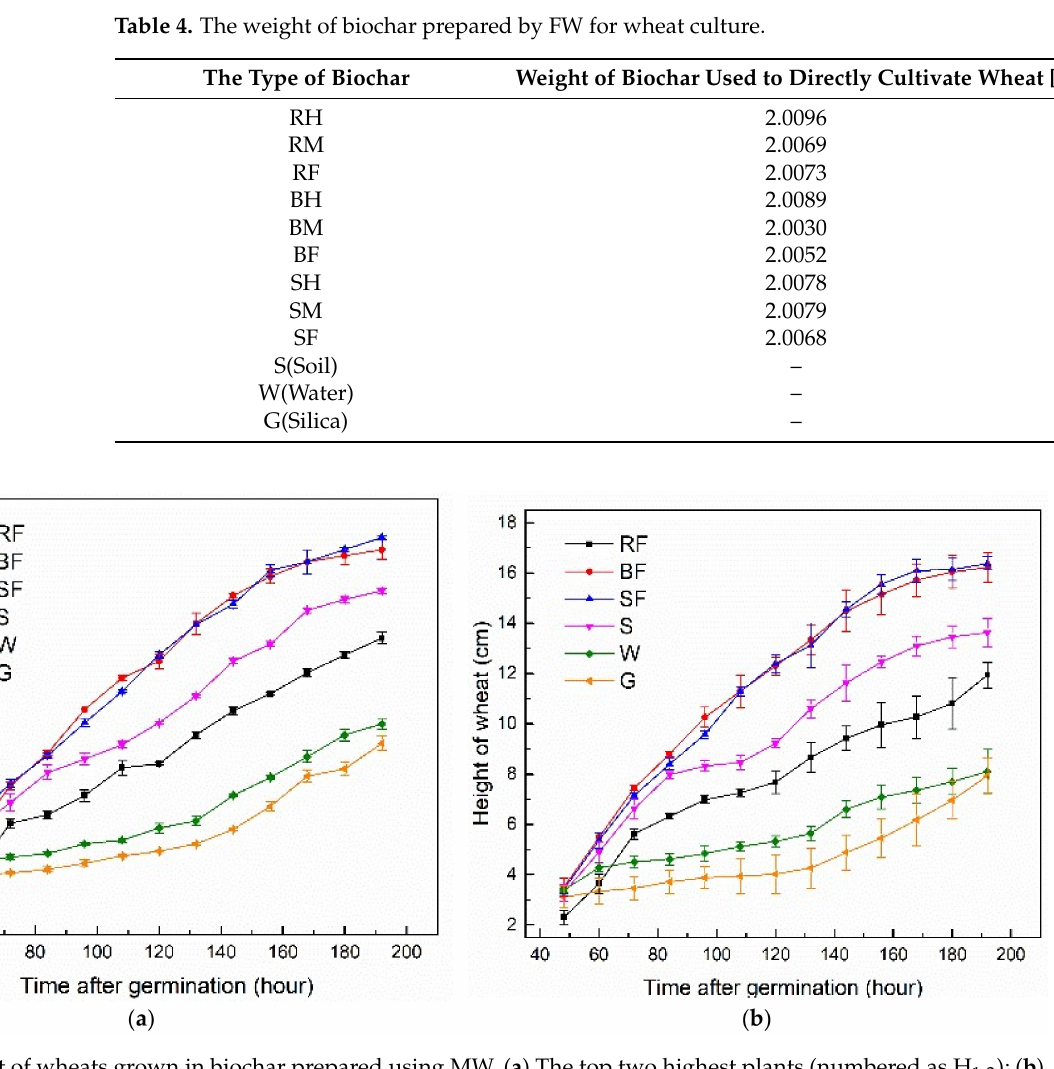
Figure 8. Height of wheats grown in biochar prepared using MW. ( a ) The top two highest plants (numbered as H 1-2 ); ( b ) the other six plants except the top two (numbered as H 6 ). Values are presented as mean ±